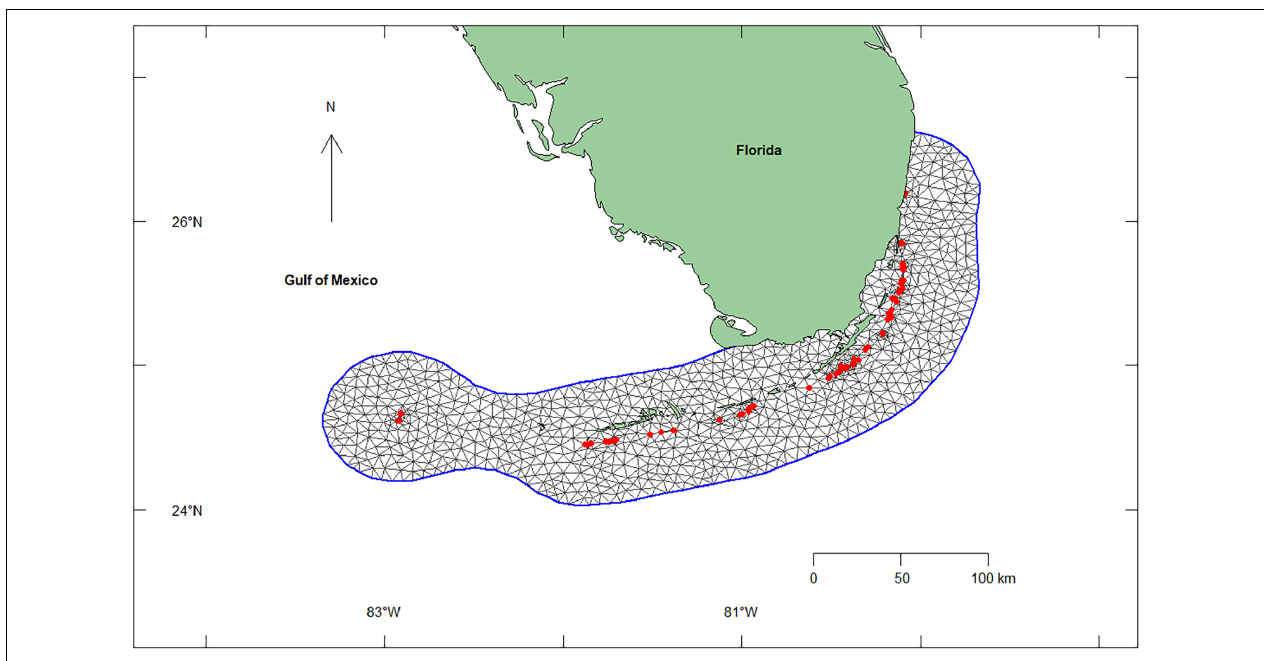
FIGURE 1 | Study sites (red dots) and a constrained refined Delaunay triangulation mesh (outlined in blue) used in the Integrated Nested Laplace Approximation (INLA) model for 22,634 Acropora cervicornis outplants in 7 subregions and 67 reefs along the Florida reef tract, United States from 2012 to 2018. The mesh uses the A. cervicornis critical habitat as the inner boundary and a buffer around that critical boundary to avoid edge effects.